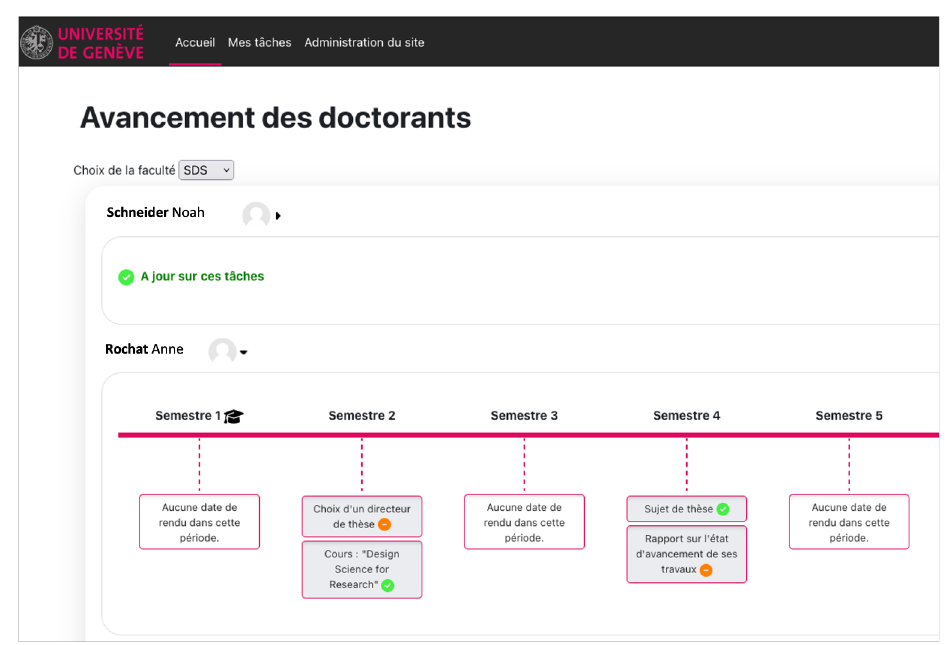
Figure 9: PhD study advisor role - Monitoring of enrolled PhD